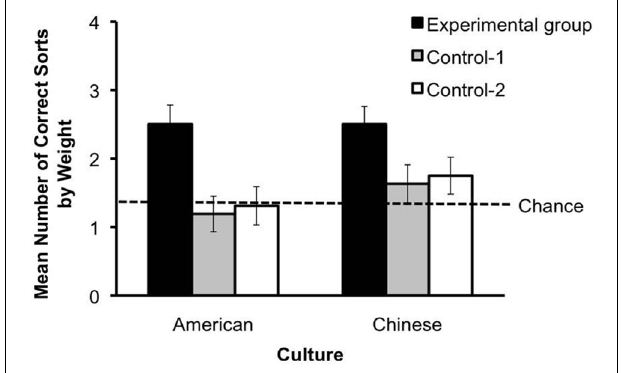
FIGURE 2 | Mean number of weight sorts ( (cid:6) SE) as a function of test group and culture.